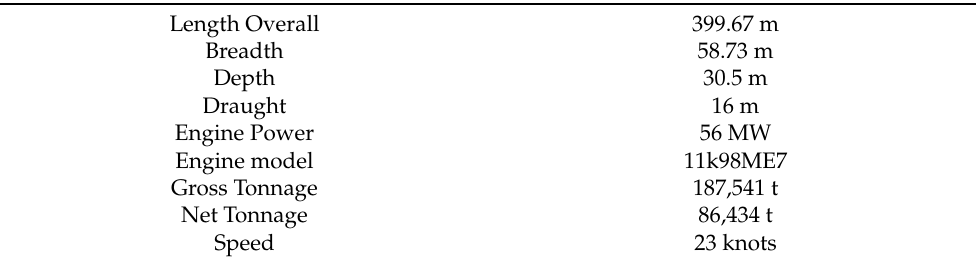
Table 8. Main data considered for the CSCL Globe 19,000 twenty-foot equivalent unit container